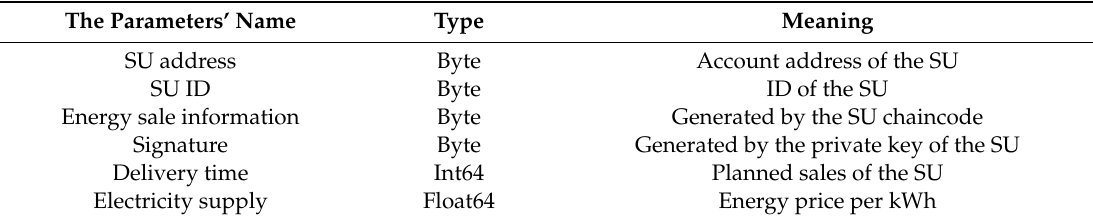
Table 4. Basic elements of the SU chaincode.